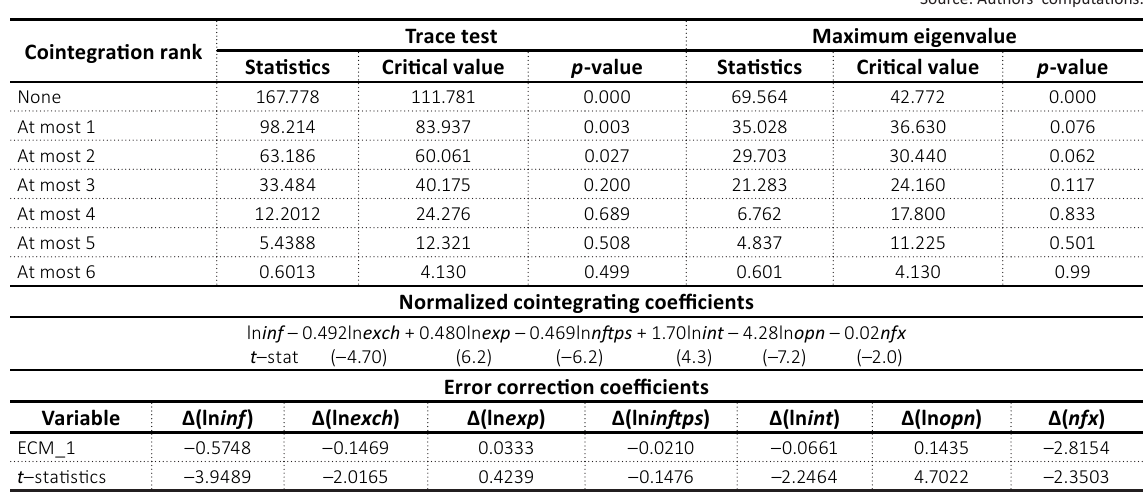
Table 5. Johansen cointegration rank test